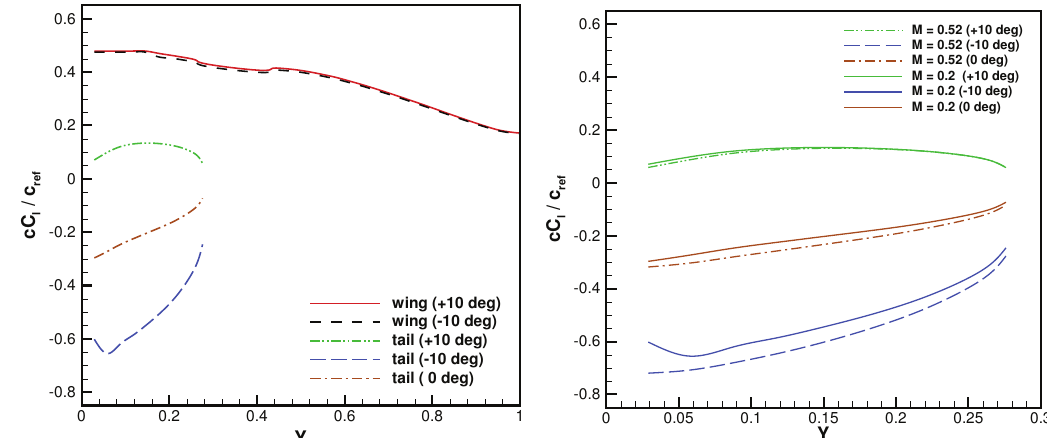
Figure 24. Elevators: spanwise loading on wing and horizontal tailplane, for different deflections and flight